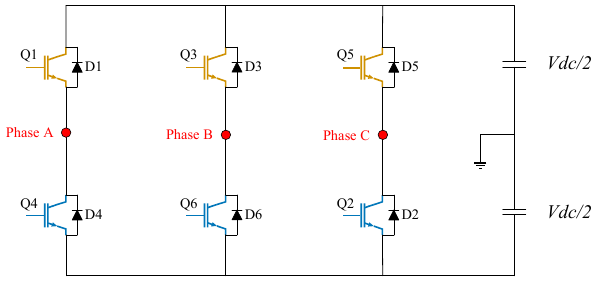
Figure 4. Three-phase two-level VSC converter.